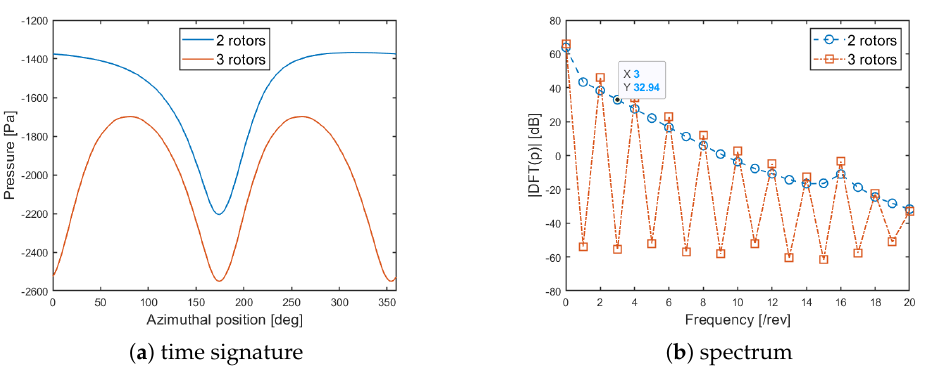
Figure 6. Aerodynamic pressure evaluated at y = 0.75 R and x = 0.25 c on rotor #1: comparison between twin- and three-propeller